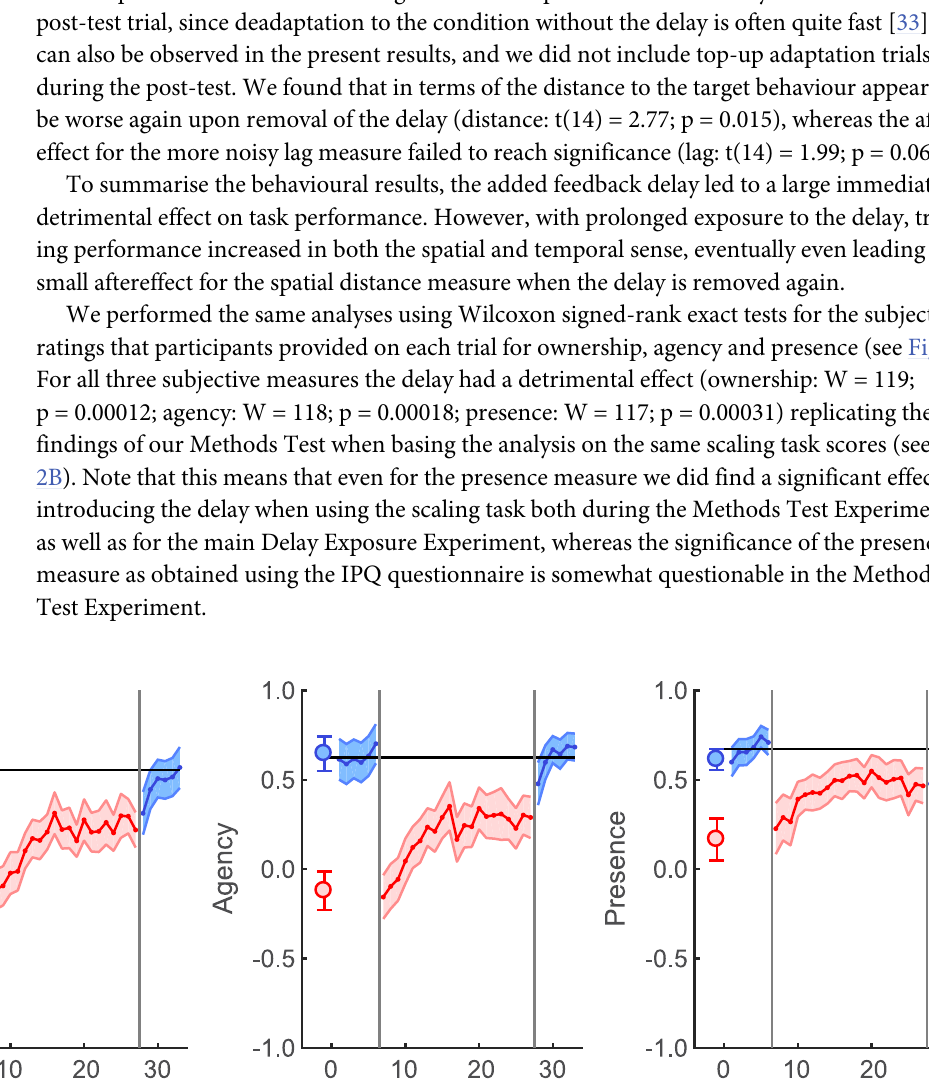
PLOS ONE | https://doi.org/10.1371/journal.pone.0205145 October 24,